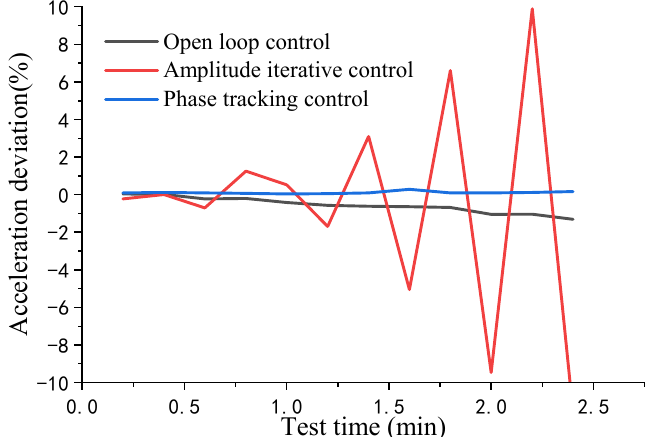
Figure 13. Amplitude stability comparison in the 8000 m/s 2 interval.